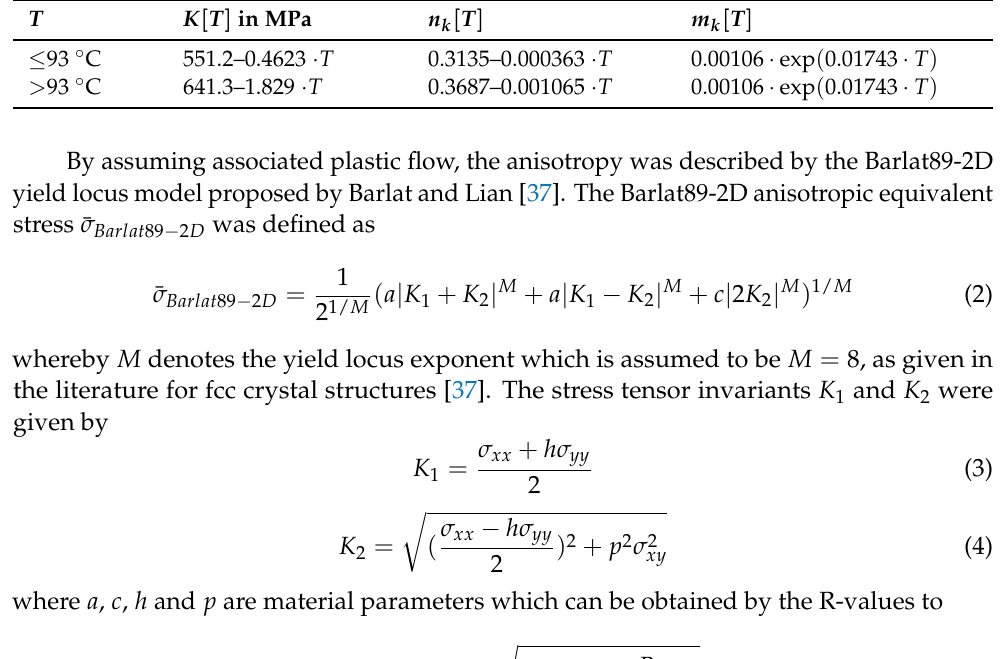
Table 1. Temperature dependent material parameters of Equation (1) adapted from Abedrabbo et al. [11]. T K [ T ] in MPa n k [ T ] m k [ T ] ≤ 93 ◦